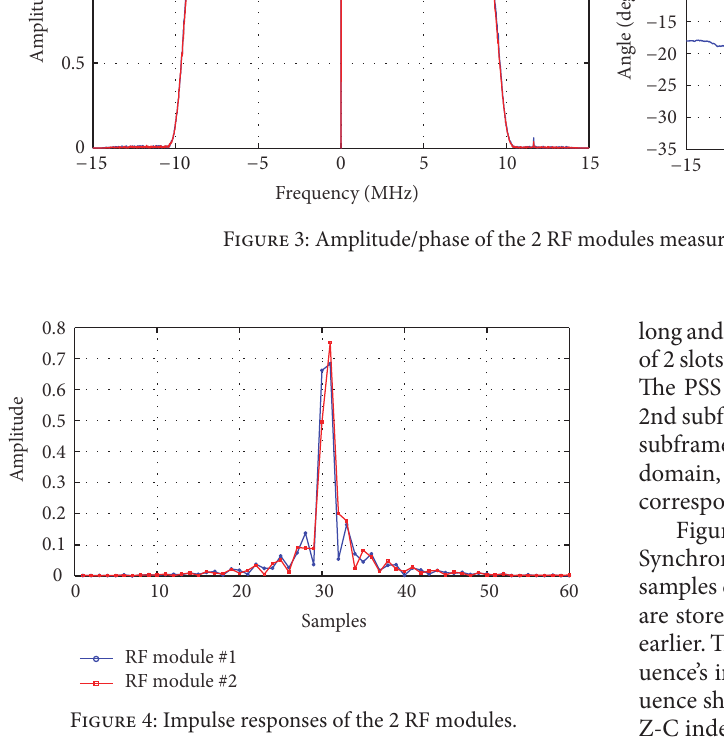
Input 3 . LTE data stream to be transmitted through the 2nd antenna element, 𝑥 2 (𝑛) , becomes the 3rd input signal, B , of Calibration Algorithm Part shown in Figure